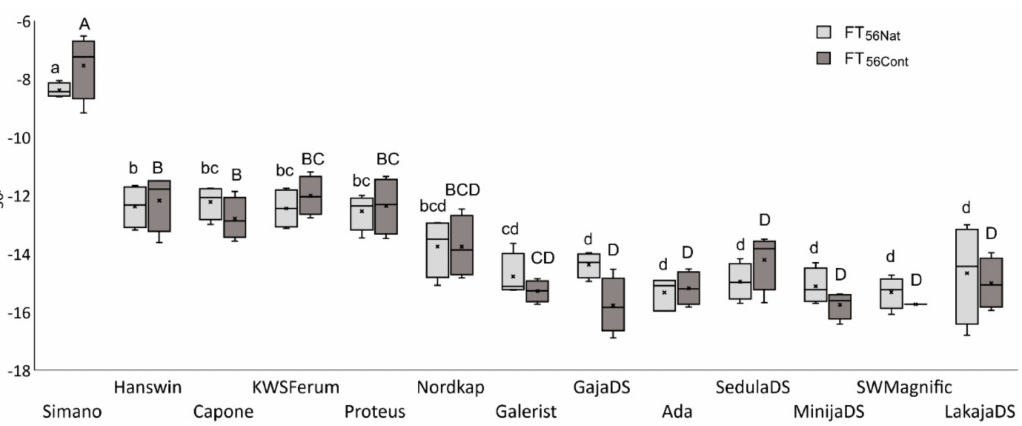
Figure 5. Freezing tolerance measured as LT 30 values of 13 winter wheat cultivars acclimated at 2 ◦ C for 56 days under natural FT 56Nat and controlled FT 56Cont conditions. LT 30 boxplots topped by the same letter are not significantly different, with freezing tolerance after acclimation under natural conditions specified in a lower case and acclimation under controlled conditions in an upper case (Tukey HSD, p < 0.05). Means ± SD, n =